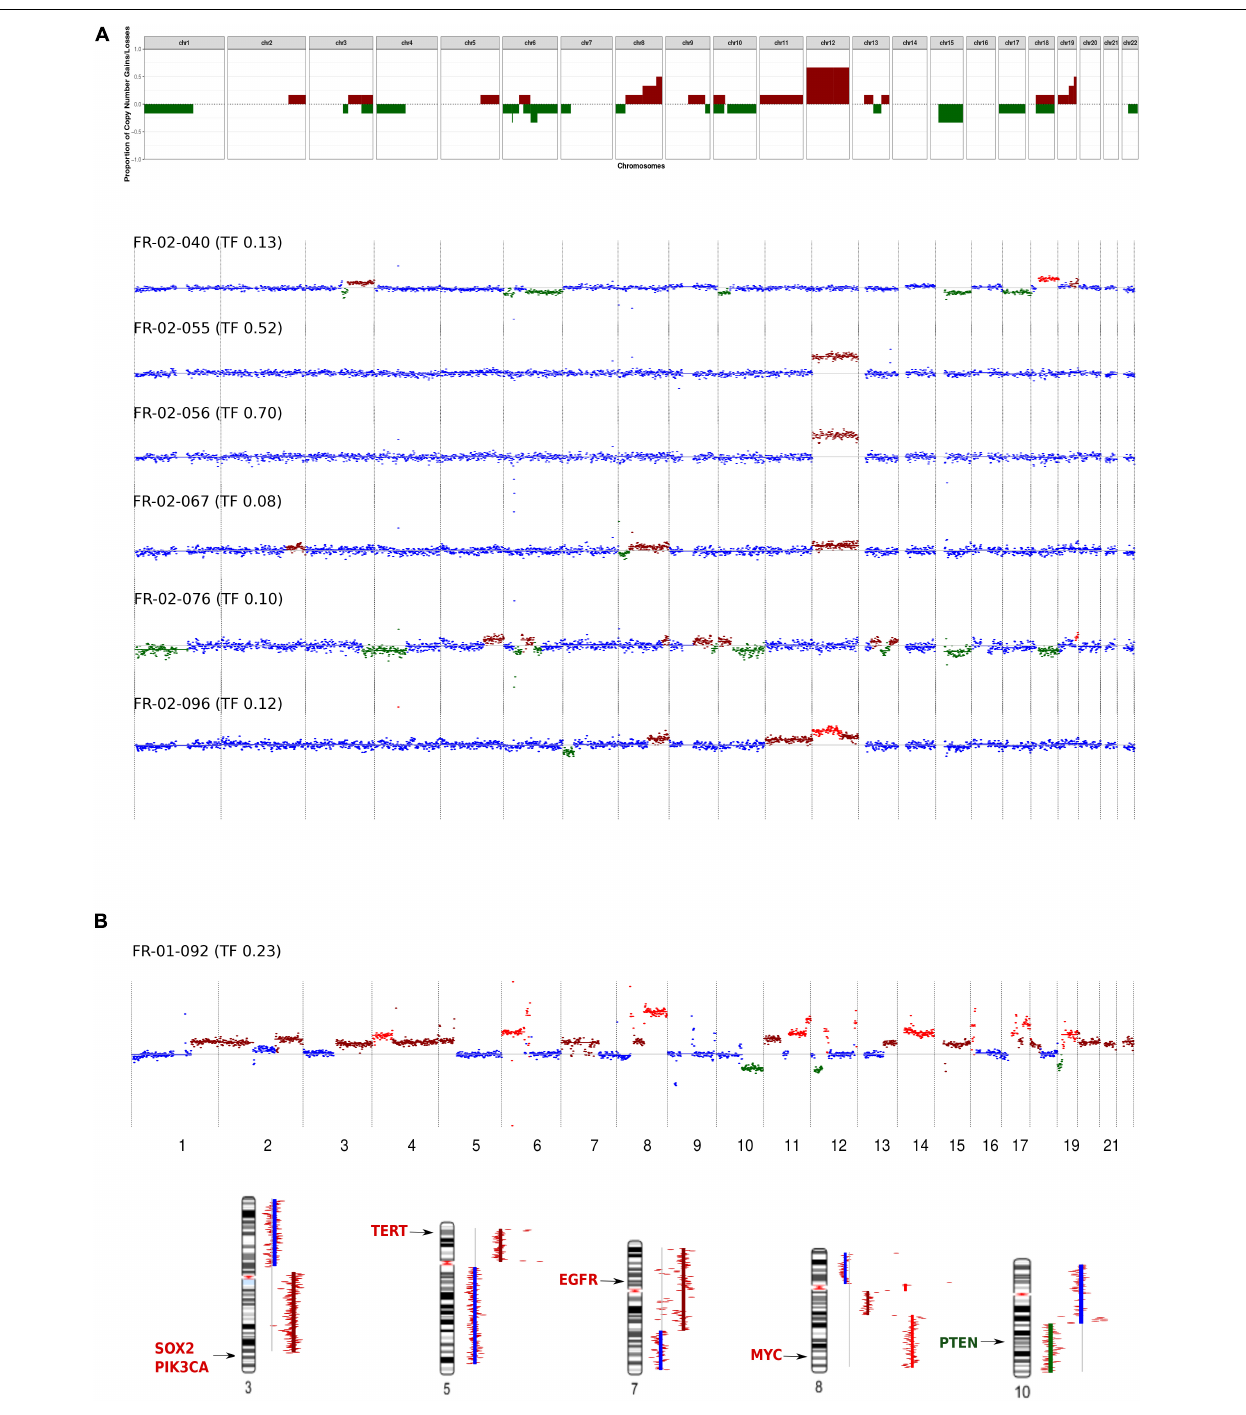
FIGURE 3 | Genome-wide copy number alteration (CNA) landscape in patients with a tumor fraction > 5%. (A) Cell-free DNA (cfDNA) results from six immunodeficient non-Hodgkin lymphoma patients. Top, frequency of copy number variation (CNV) regions detected by low-coverage whole-genome sequencing of cfDNA. Bottom, CNV pattern for each patient. The plots show the CNV log 2 ratios between the cfDNA sample and the healthy donor (HD). Neutral copy numbers are shown in blue, copy number gains are shown in dark red, copy number amplifications are shown in red, and copy number losses are shown in green. (B) cfDNA results from the non-small-cell lung cancer (NSCLC) patients infected with human immunodeficiency virus. Top, CNV pattern. Bottom, genes affected by CNA known to be associated with NSCLC, and their chromosomal locations.